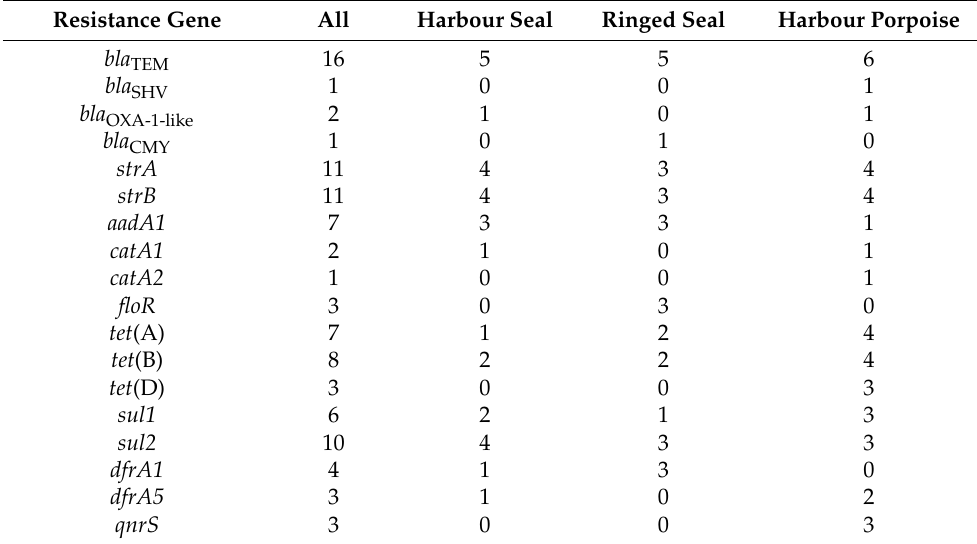
Table 1. Detected resistance genes. Total number of resistance genes as well as number of resistance genes per species. In the three isolates of grey seals no resistance gene was detected.